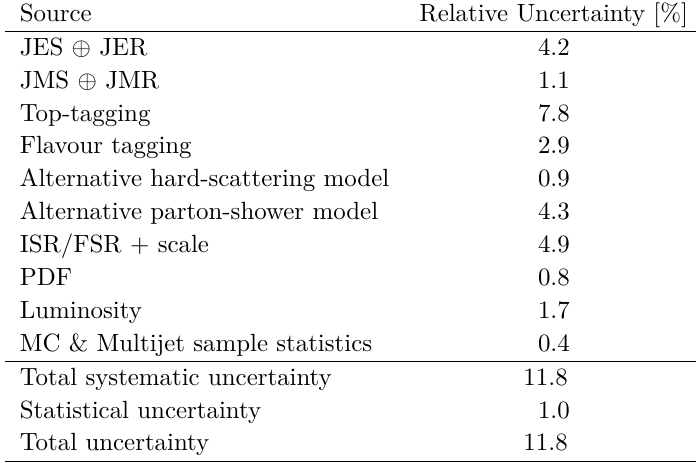
Table 3 . Summary of the largest systematic and statistical relative uncertainties for the total particle-level fiducial phase-space cross-section measurement. The uncertainties that are signifi- cantly less than 1% are not